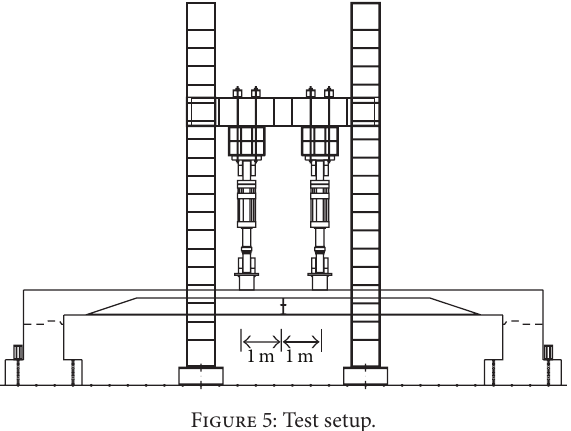
Figure 5: Test setup.